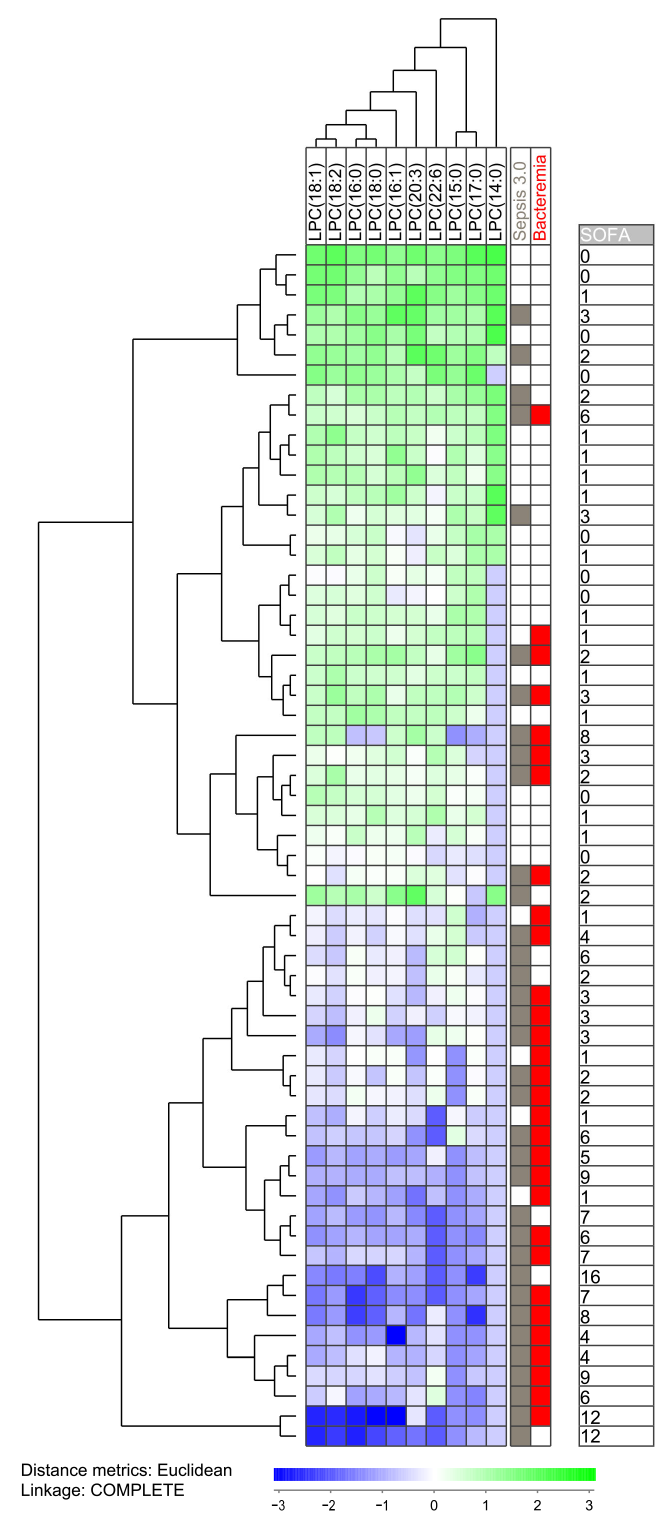
Figure 2. Subclassification of sepsis patients based on their lysophosphatidylcholine profile. The analysis was based on the lysophosphatidylcholines (LPC) (i) showing detectable levels for at least 10 patients and (ii) showing a statistically significant difference when comparing patients with and without bacteremia. All 60 patients were included in the analysis. The characteristics of each individual patient (organ failure, bacteremia, total SOFA score) are indicated to the right in the figure.